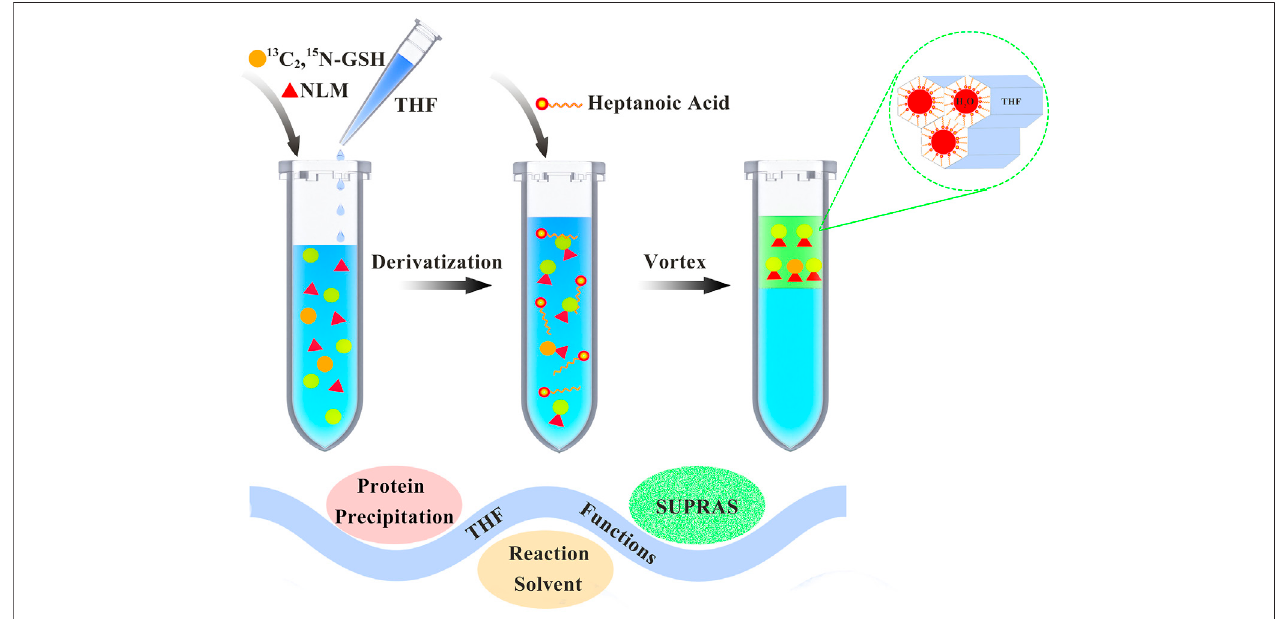
FIGURE 1 | Schematic diagram of thiol-maleimide derivatization and supramolecular solvent-based microextraction.